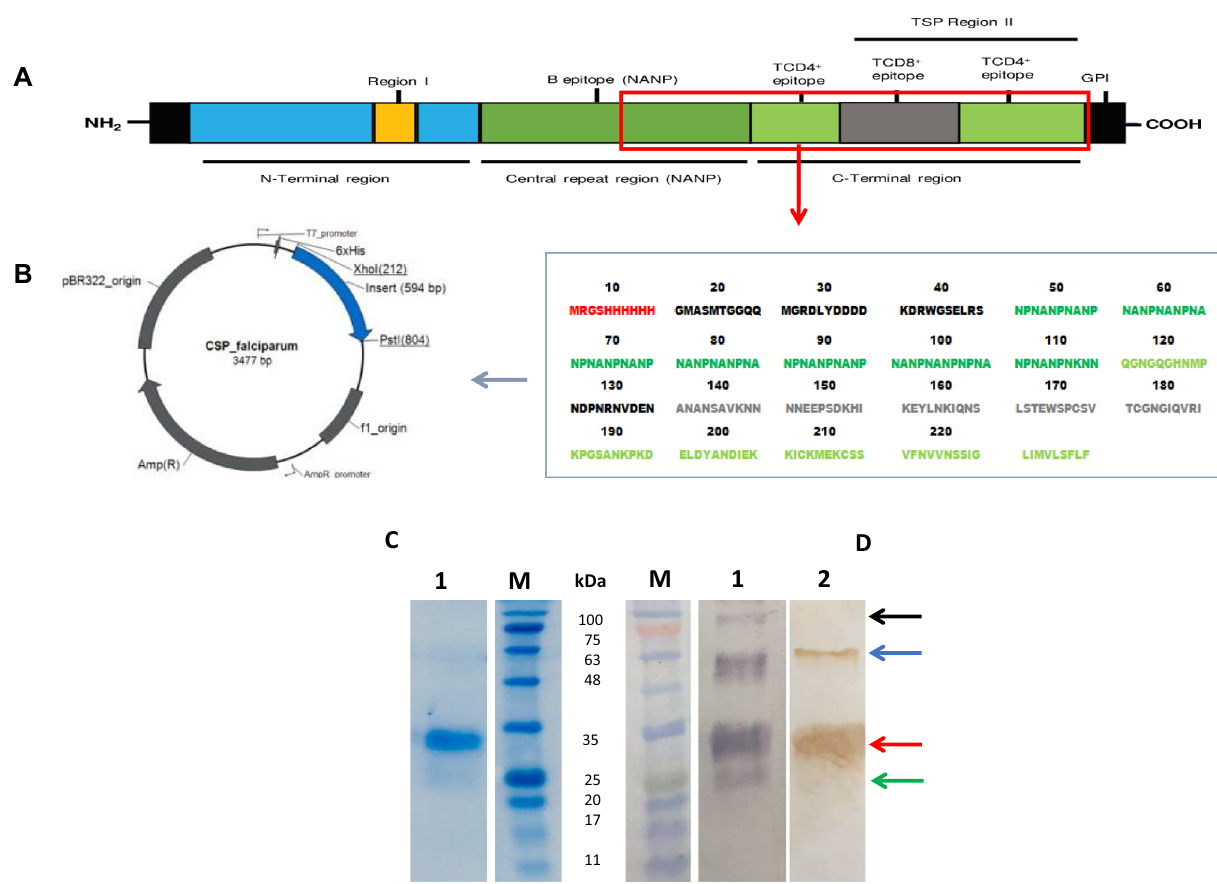
Figure 1. Construction and confirmation of the expression of the rPfCSP. ( A ) A graphical representation of CSP. The region corresponding to the construction of the r Pf CSP developed in this study is highlighted; ( B ) Amino acid sequence corresponding to r Pf CSP and the expression plasmid in which it was inserted (pRSET A, Invitrogen); ( C ) SDS-PAGE analysis of recombinant protein, BLUeye Pre-stained ladder (Sigma-Aldrich) (lane M), and electrophoretic profile of r Pf CSP elution (lane 1); ( D ) western blot confirming the r Pf CSP antibodies recognition. Lane 1: anti-HisG monoclonal antibody recognition. Black, blue, red, and green arrows indicate ~ 120, 63, 33, and 25 kDa proteins, respectively. Development step was performed using BCIP/NBT chromogenic substrate from Western breeze kit (Invitrogen); Lane 2: anti- Pf CSP monoclonal antibody (BEI Resources, cat. No. MRA-183A 2A10) recognition. Blue, red, and green arrows indicate 63, 33, and 25 kDa proteins, respectively. Development step was performed using 3,3’-diaminobenzidine (DAB, Sigma-Aldrich. cat. No.